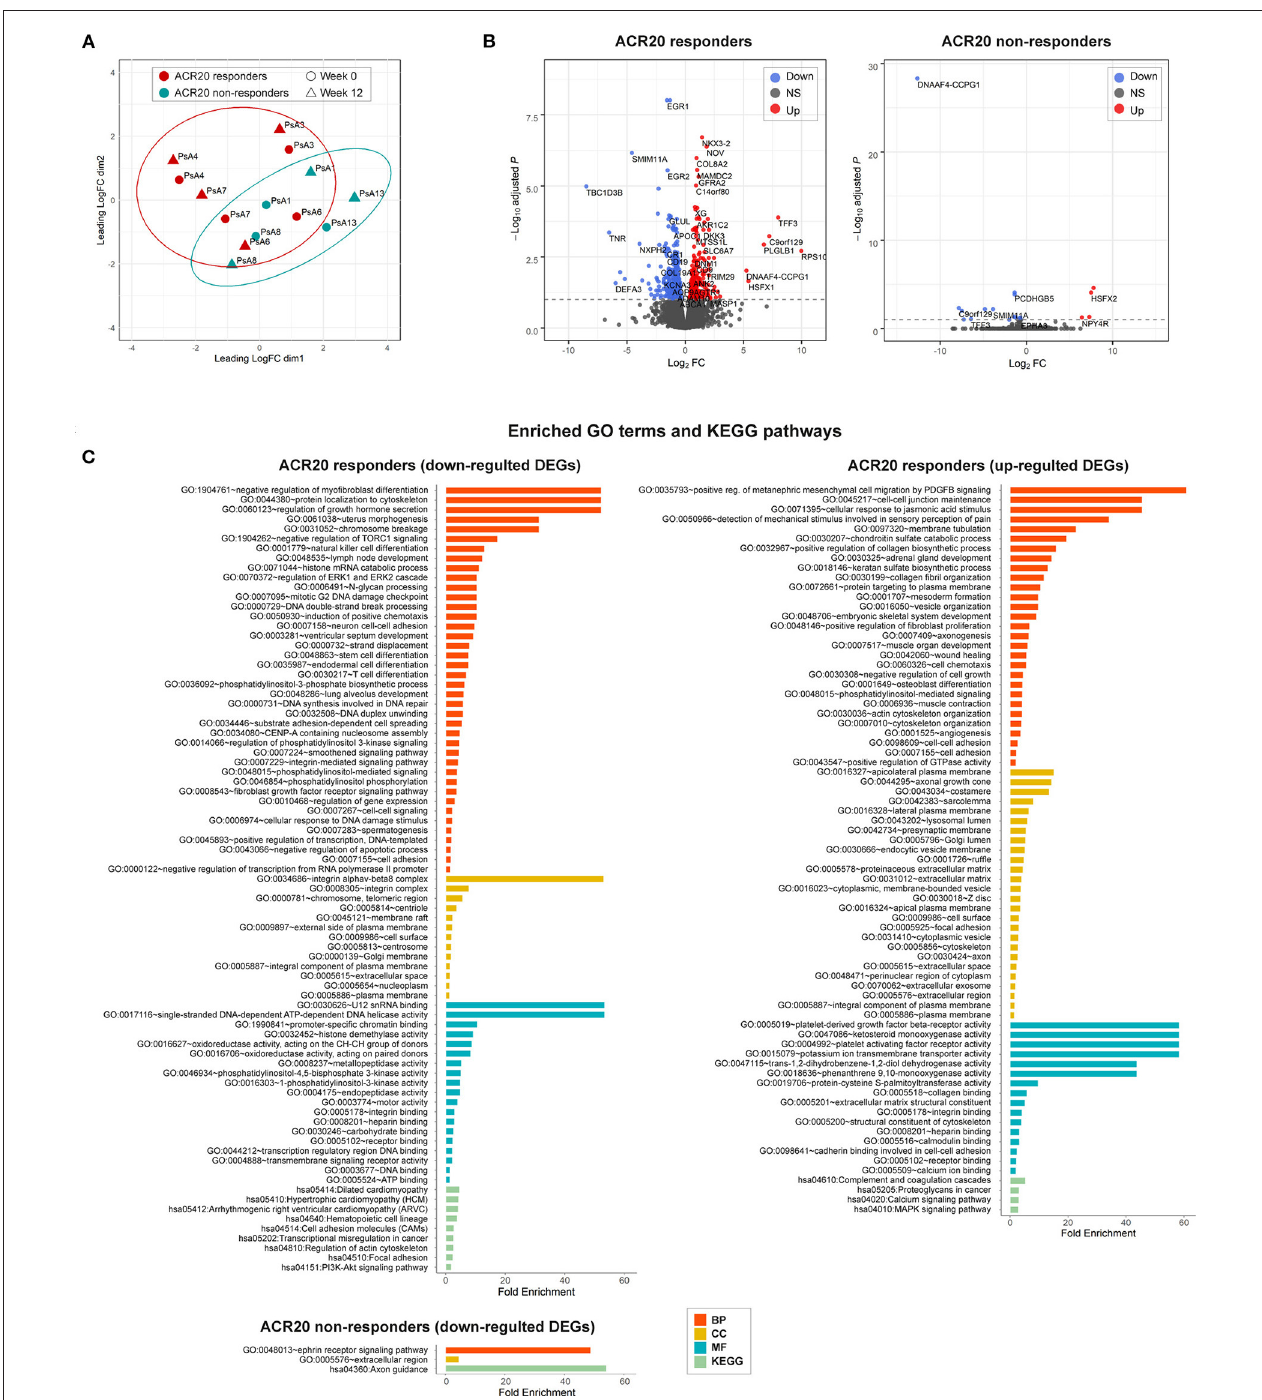
FIGURE 5 | Differential gene expression and pathway analysis of ACR20 responders and non-responders to ustekinumab treatment in a post-hoc explorational analysis. (A) Multidimensional scaling (MDS) plot of gene expression (logCPM) in American College of Rheumatology 20% improvement criteria (ACR20) responders (red, n = 4) and ACR20 non-responders (blue, n = 3) reveals separation of the two groups. (B) A volcano plot identifying significantly differentially expressed genes (DEGs) of ACR20 responders and non-responders to IL-23p40/IL-12p40 blockade with ustekinumab (FDR < 0.1, dashed line): red, upregulated genes; blue, downregulated genes; black, non-differentially expressed genes. (C) The enriched ( p < 0.05) gene ontology (GO) terms and KEGG pathways of upregulated and downregulated DEGs in psoriatic arthritis synovium in response to the treatment with ustekinumab identified by DAVID for ACR20 responders and non-responders. DEGs between pre- and post-treated groups were categorized into the three main categories of gene ontology classification: BP, biological process; CC, cellular component; MF, molecular function.